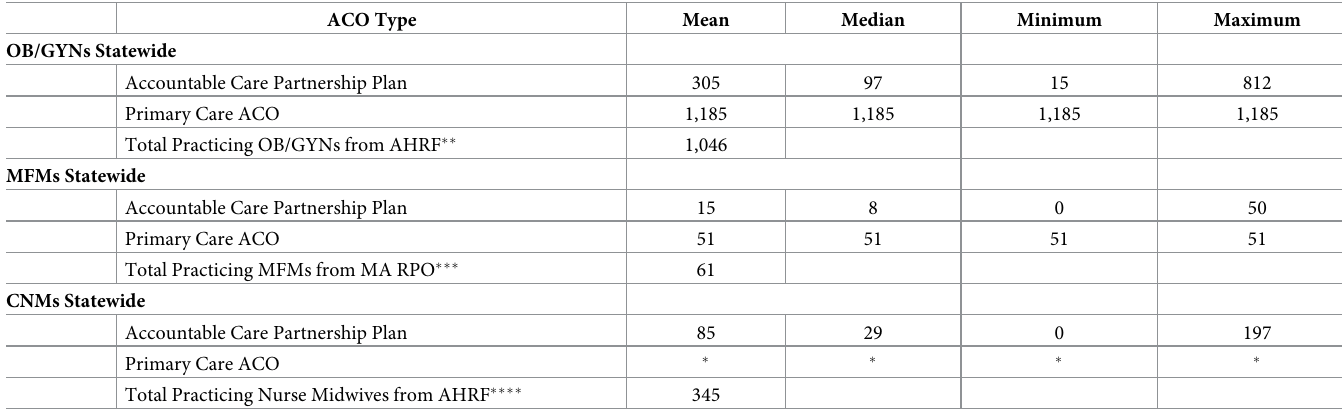
Table 1. Descriptive statistics of maternity care clinician